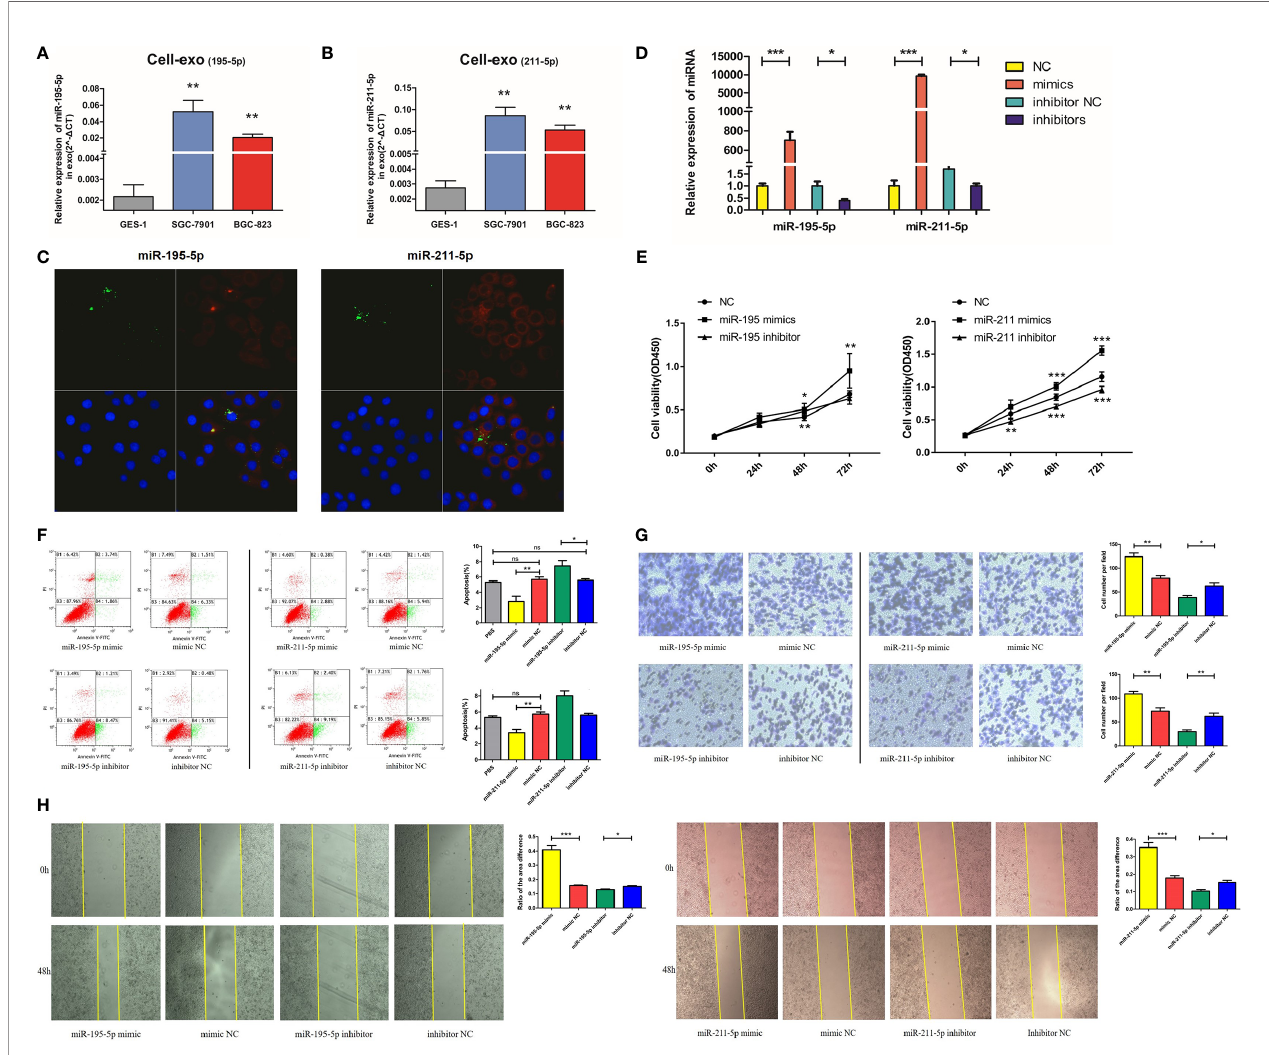
FIGURE 4 | Upregulated miR-195-5p/miR-211-5p levels augmented the invasive, migratory and proliferative capabilities of GC cells, while suppressing their rate of apoptosis. (A, B) . MiR-195-5p and miR-211-5p expressions in cell exosomes were analyzed with qRT-PCR. (C) . Traces of miRNAs in the cell exosomes were observed under a laser confocal microscope (left: miR-195; right: miR-211), for single large image: (1)the upper left: trace of GFP-labeled exosomes(green); (2)the upper right: trace of Cy-3 labeled miR-195/211mimics(red); (3)the lower left: DAPI-stained nuclei; (4)the lower right: merge of all groups. (D) . MiR-195-5p and miR- 211-5p up and down-regulated ef fi ciency in SGC-7901 cells. (E) . Cell proliferation was measured using CCK-8 assay. (F) . Flow cytometry was utilized for analysis of SGC-7901 apoptosis after up or down-regulating miR-195-5p/miR-211-5p levels, the early apoptotic cell ratio(%) was recorded and is presented in the column chart. (G, H) . Transwell and wound healing assays of miR-195-5p/miR-211-5p mimics/NC/inhibitor/inhibitor-NC transfected SGC-7901 cells (*p-value<0.05, **p- value<0.01, ***p-value<0.001, n.s., no signi fi cance). The representative images of cells that had migrated and had been invaded were are